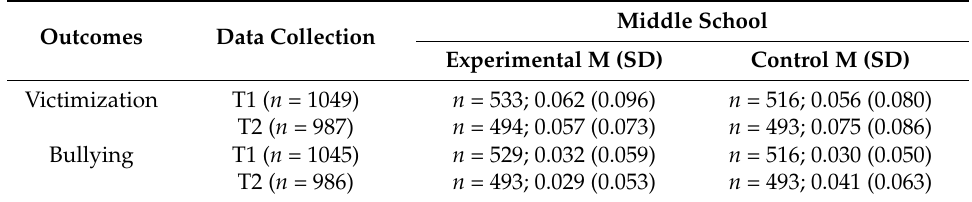
Table 1. Descriptive statistics for the behavioral outcomes: means (M) and standard deviations